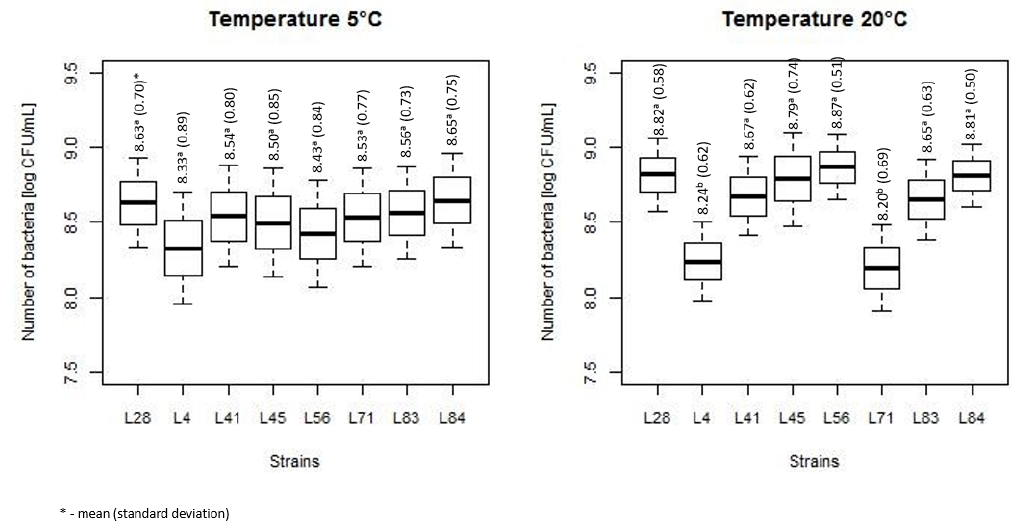
Figure 1. The summarized number of bacteria for various strains (the horizontal line is the mean, the box spans represent standard error and the whiskers represent 95% confidence interval).